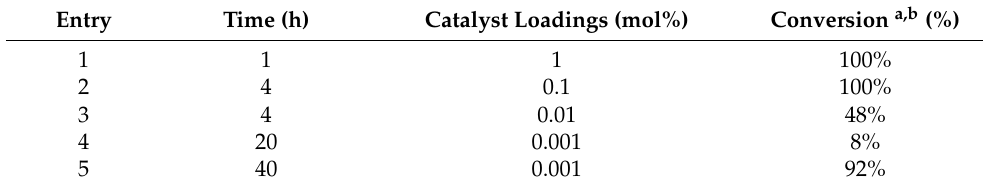
Table 6. a Reaction conditions: 0.250 mmol of 1a, 0.275 mmol of 2a, 0.300 mmol K 2 CO 3 , Pd (EcoPd 1